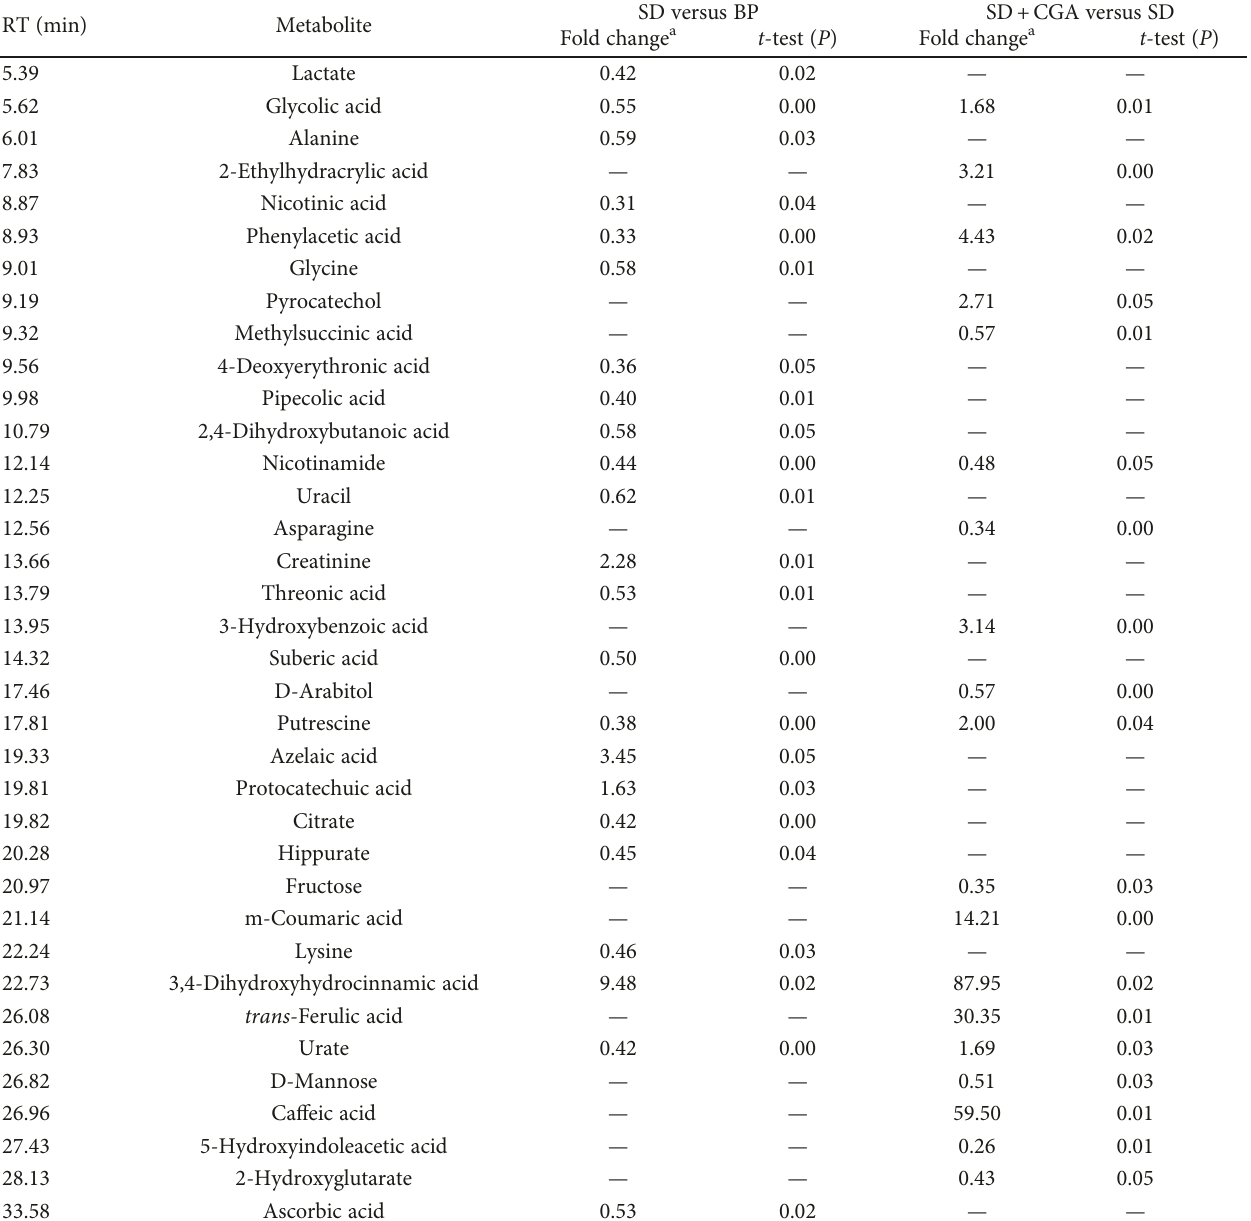
Table 2: Discriminating urinary metabolites of three